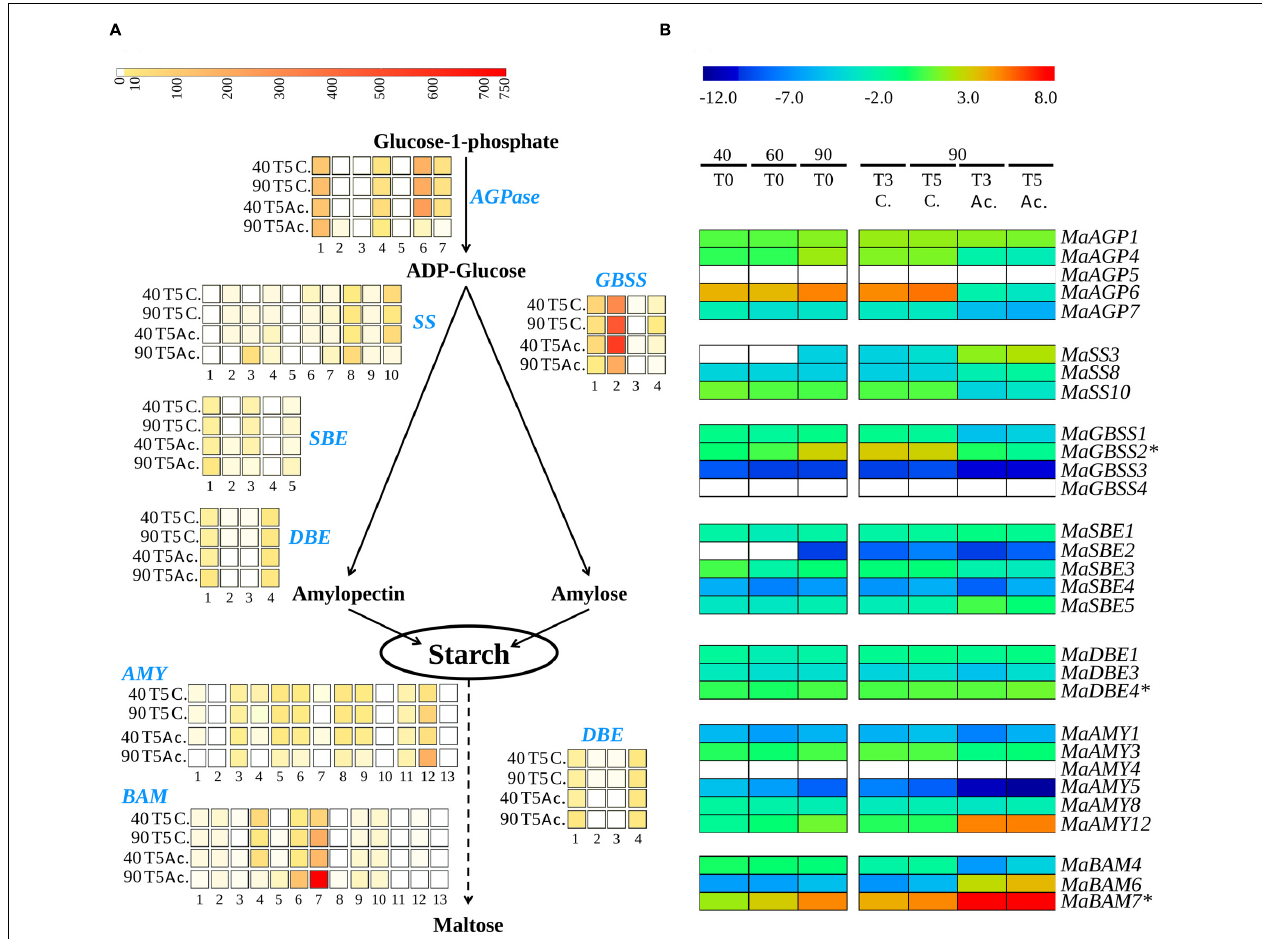
FIGURE 9 | Expression profiles of starch metabolism genes in banana fruits. (A) Heatmap visualization of RNA-seq data derived expression levels for the six studied gene families (D’Hont et al., 2012).The four lines correspond to four libraries from banana fruits harvested at 40 and 90 days after flowering and not treated (40T5 C., 90T5 C.) or treated for 24 h with acetylene (40T5 Ac., 90T5 Ac.). RNA-Seq analysis was carried out on RNA extracted 4 days after acetylene treatment (T5) Each column corresponds to a banana gene (see nomenclature in supplementary Table S5). Transcript abundance was normalized in RPKM (reads per kilobase of exon per million mapped reads on banana gene models) and indicated with a color scale from white (not expressed) to red (750 RPKM). The dotted arrow indicates that other enzymes are necessary for the complete conversion. (B) Heatmap visualization of relative mRNA abundances from qRT-PCR data. The libraries correspond to cDNA samples from banana pulp tissue. 40T0, 60T0, and 90T0 correspond to fruits harvested at 40, 60, and 90 DAF respectively. 90T3 and 90T5 correspond to fruits harvested at 90 DAF and treated 24h with acetylene (Ac.) or not treated (C.) and stored two or four additional days, respectively. Relative transcript abundance was normalized with the banana Actin2 reference gene and transformed in log2. Gene expression levels are indicated with a rainbow color scale from blue (very weakly expressed) to red (very strongly expressed) and white boxes correspond to genes without detected expression. Stars indicate previously described banana